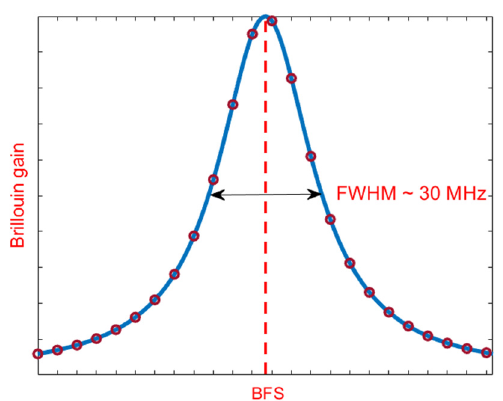
Figure 1. Brillouin Gain Spectrum in a conventional silica fiber. The red circles represent the frequencies acquired for BFS extraction.